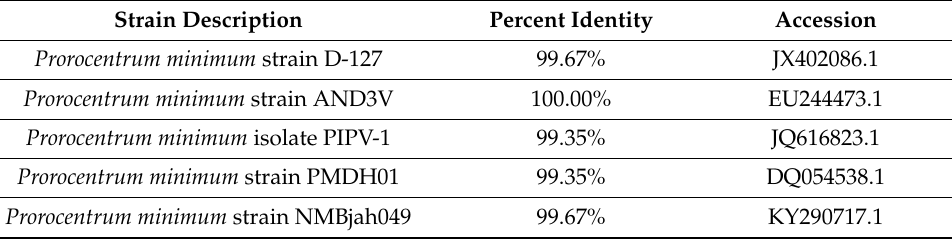
Table 3. Top 5 BLAST nucleotide sequence hits of the ITS rRNA sequence of P. minimum from Berowra Creek, CAWD359, as compared with sequences of P. minimum strains on the NCBI